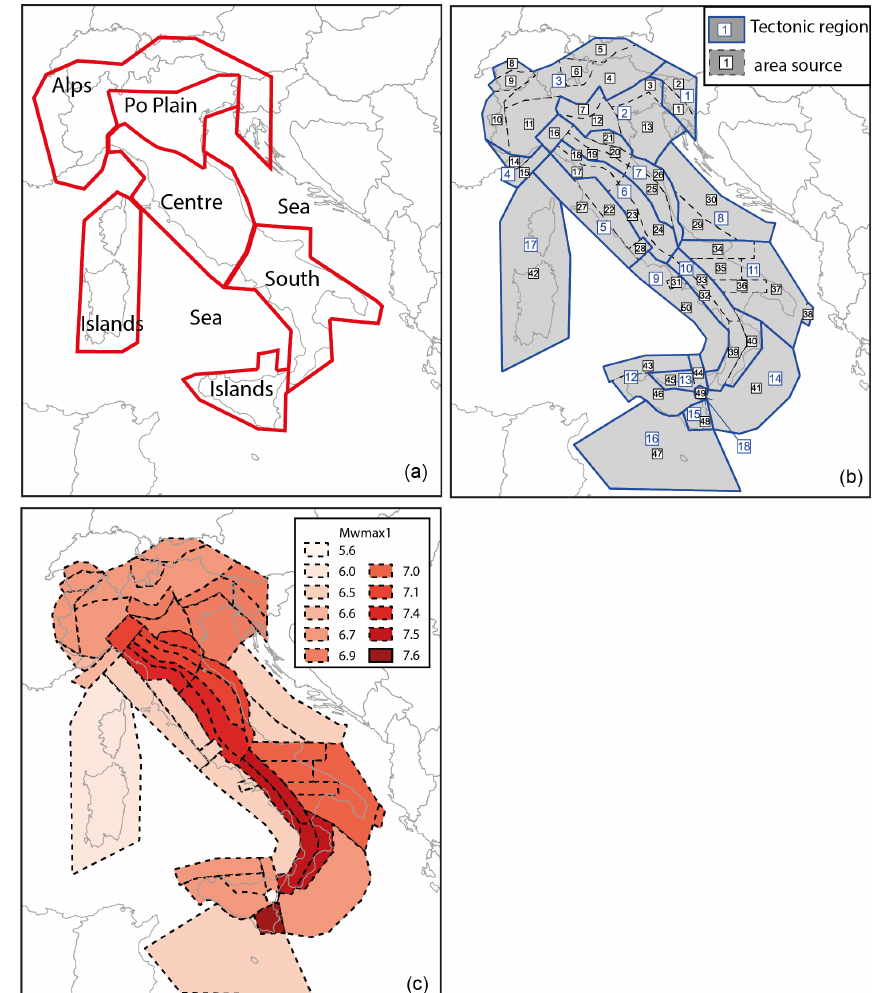
Figure 5. (a) Macroregions adopted for evaluating the completeness time intervals for the earthquake catalogue; (b) tectonic domains (blue polygons) used to calculate β overlapped to the ZS16 area sources (dashed black polygons); (c) map of the values of M w + 0 . M w max1